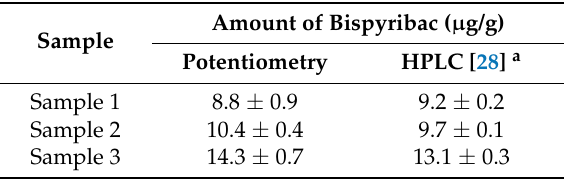
, of the proposed screen-printed ISEs. M , X